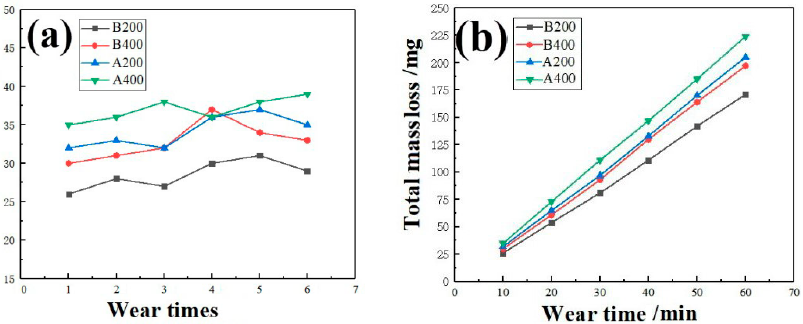
Figure 10. ( a ) Mass loss during six wear cycles; and ( b ) total mass loss verses wear time curves.